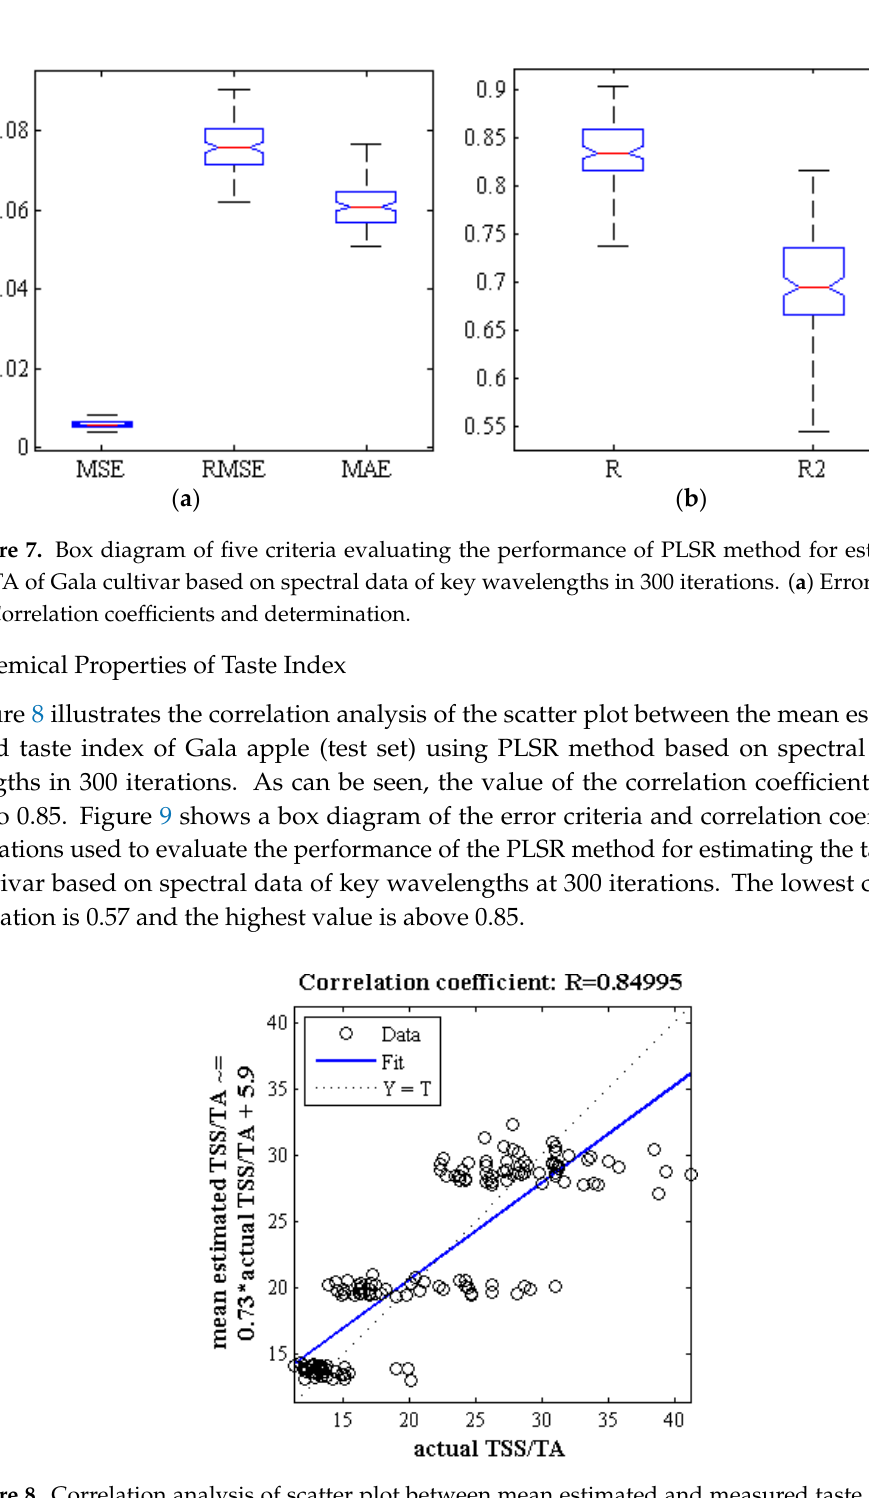
Figure 6. Correlation analysis of scatter plot between mean estimated and measured chemical properties of TA of Gala cultivar using PLSR method based on spectral data related to key wavelengths in 300 iterations.